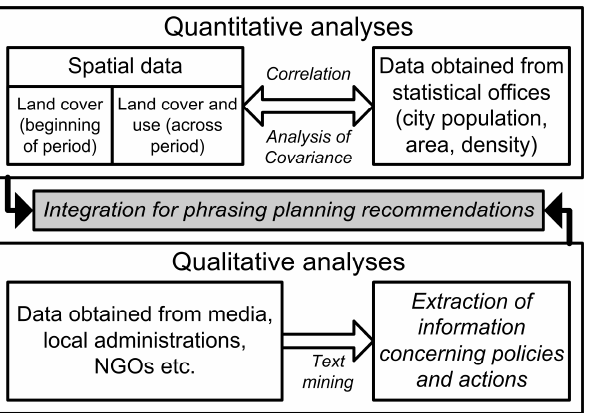
Figure 1. Outline of the study methodology, integrating quantitative and qualitative approaches to phrase planning recommendations.